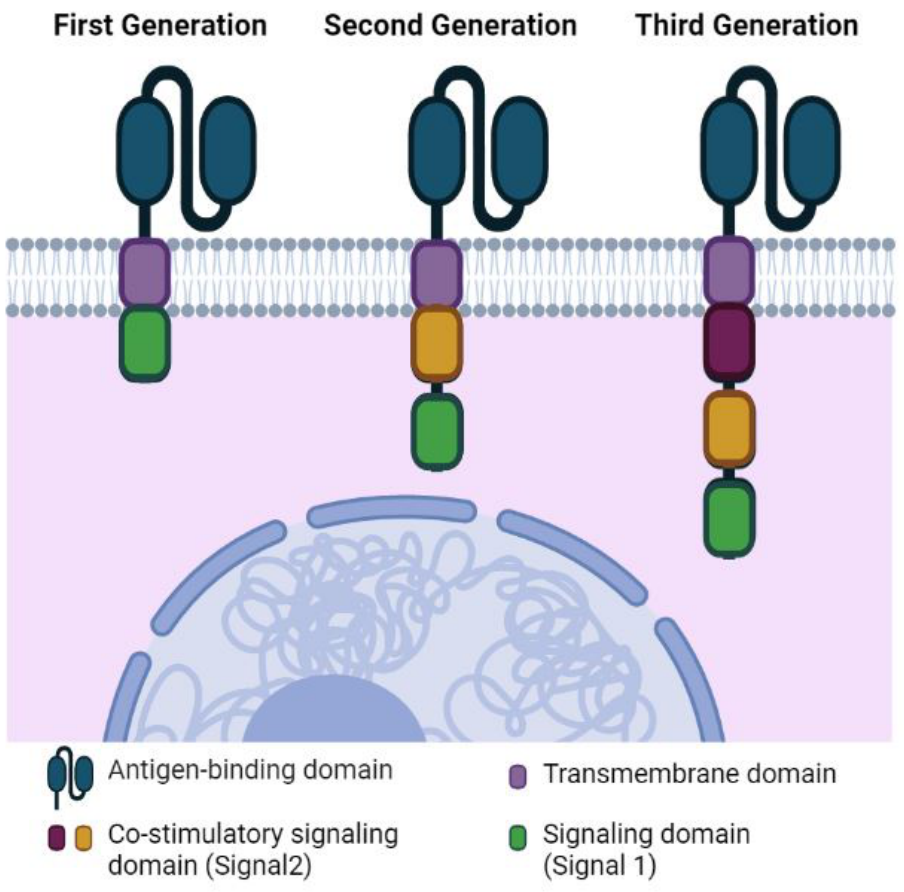
Figure 1. Evolving CAR designs in engineered T cells. The first-generation CARs contain an antigen-binding domain, transmembrane domain (TM), and a signaling domain (typically CD3 ζ ) that provides “signal 1” to activate T cells. A costimulatory signaling domain that provides “signal 2” is added in second-generation CARs, and two tandem costimulatory signaling domains are added in third-generation CARs between TM and signal 1 domain.